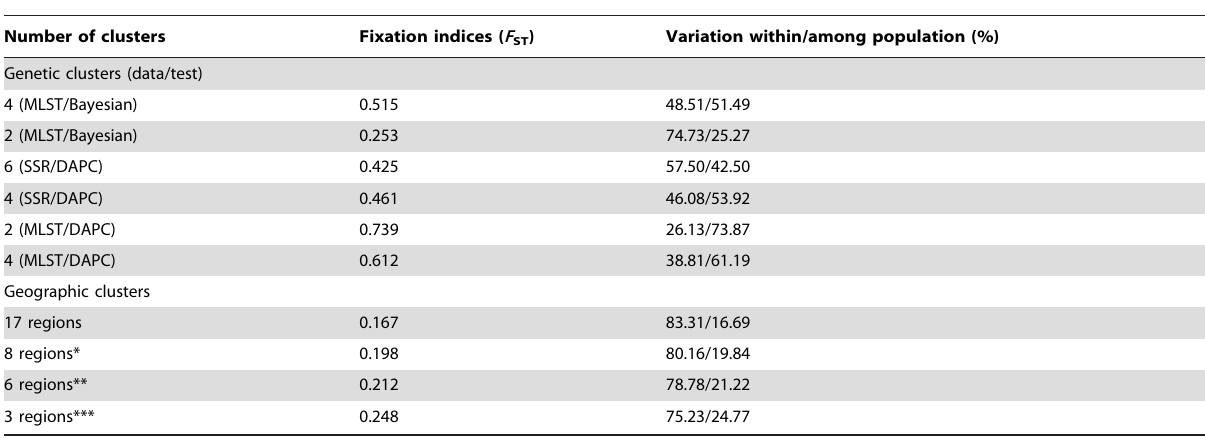
Table 3. Geosmithia morbida molecular variance determined by AMOVA of Bayesian (Structure), DAPC, and Hudson’s Permtest